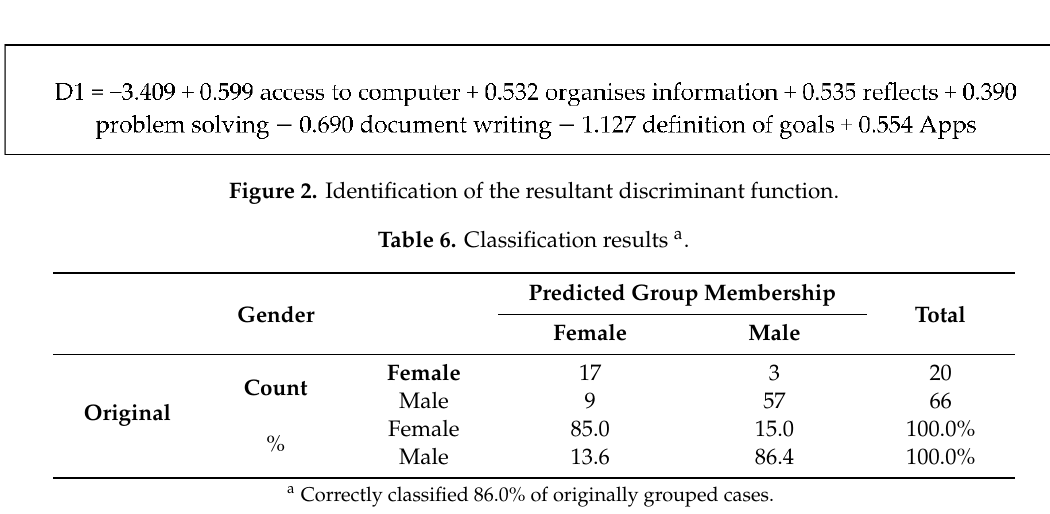
8 of 16 Table 5. Structure matrix. Structure matrix PLE